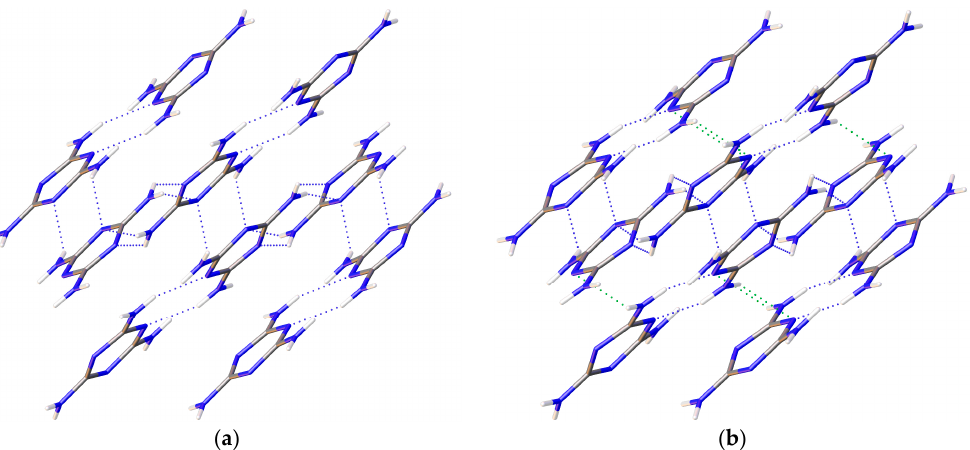
Figure 11. Hydrogen bonding network of melamine at ( a ) low (0.96(5) GPa) and ( b ) high (36.21(5) GPa) pressures, as viewed down <010>, displaying the layered structure. New hydrogen bonds to the central ring have been highlighted in green. Some bonds, including weak amino N-H interactions, have been omitted for clarity.